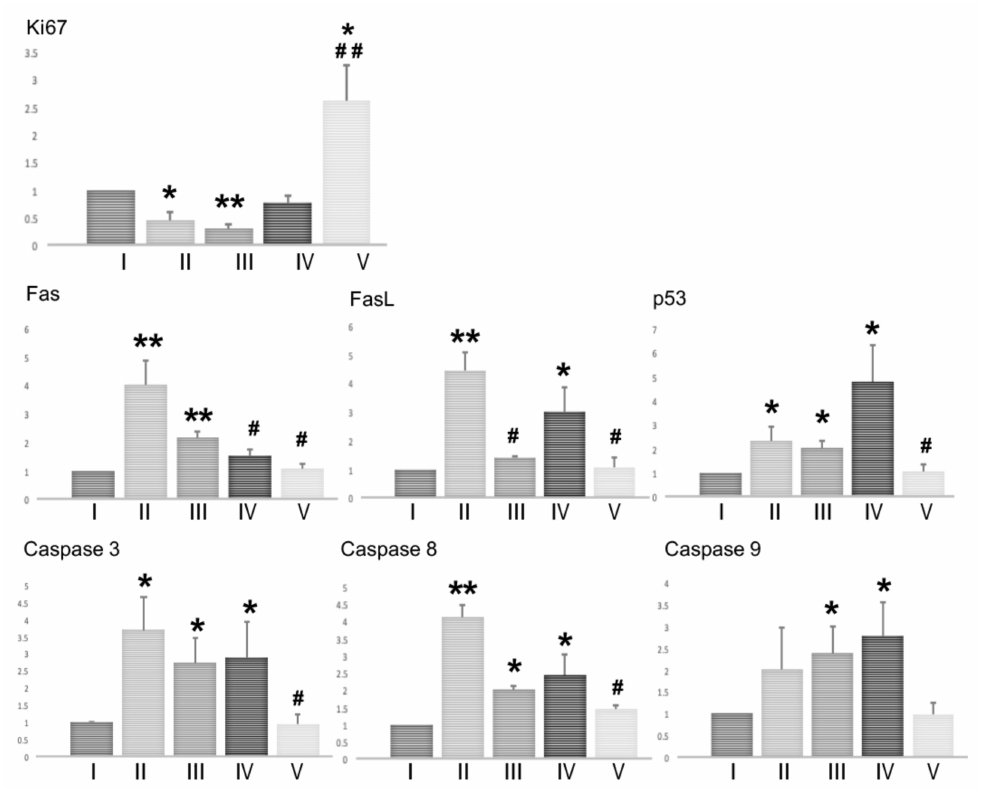
Figure 4. E ff ects of diet supplementation with Hachimi-jio-gan and / or Hochu-ekki-to on testicular proliferation and apoptosis. Expression of genes involved in proliferation ( Ki67 ) and apoptosis ( Fas , FasL , Caspase3, Caspase8, Caspase9, and p53 ) in testicular tissues of mice from each group on day 120. Data represent the mean values ± standard deviation of three mice in independent groups. * p < 0.05 and ** p < 0.01 vs. the control group; # p < 0.05 and ## p < 0.01 vs. the BSF